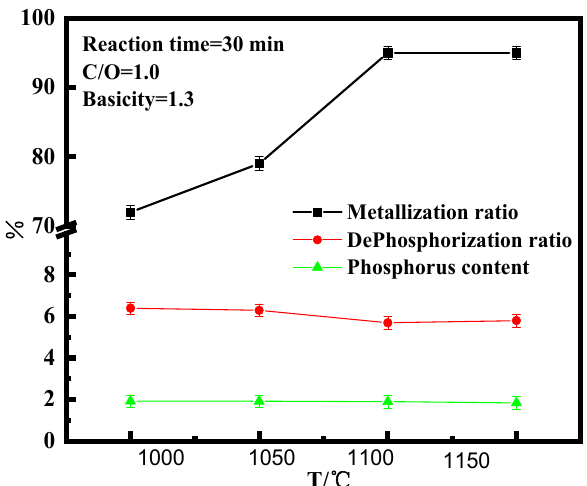
Figure 2. The effects of reduction temperature on the metallization ratio, dephosphorization ratio, and phosphorus content of iron bead.